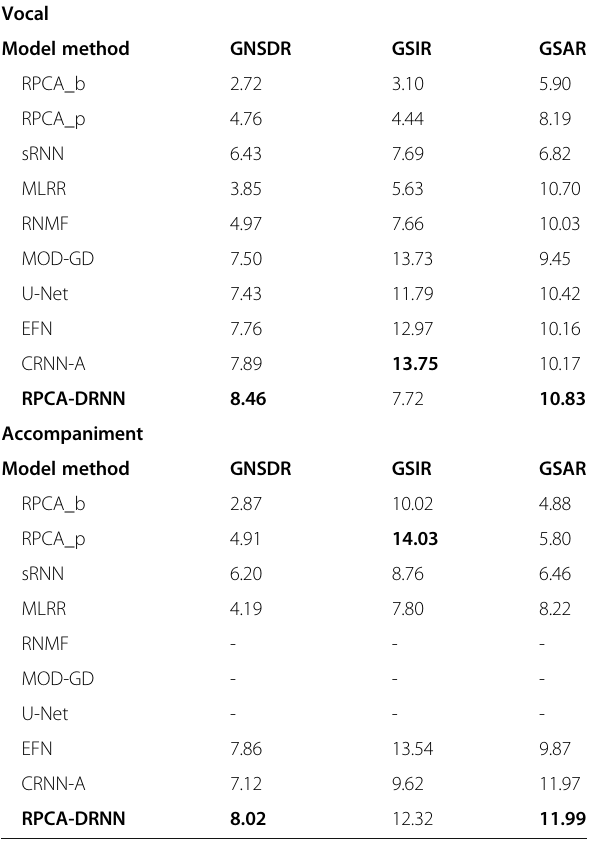
Table 3 Comparison of the GNSDR, GSIR, and GSAR scores of the proposed RPCA-DRNN method with RPCA_b,